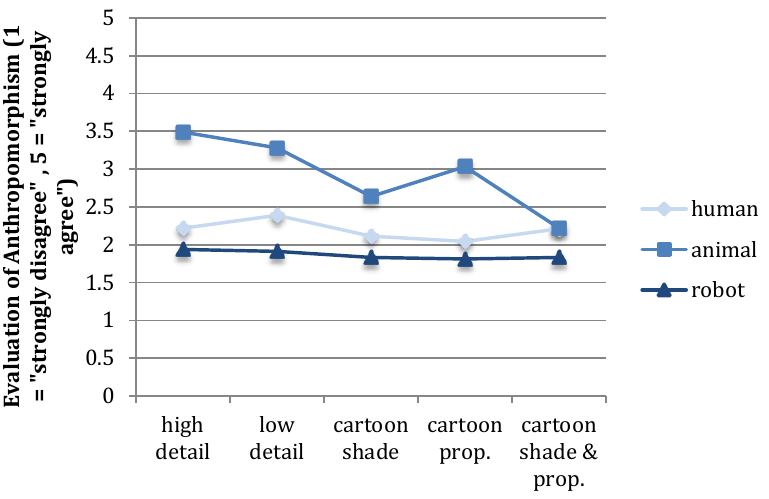
Figure 3. Interaction effect of species and realism on perceived anthropomorphism.